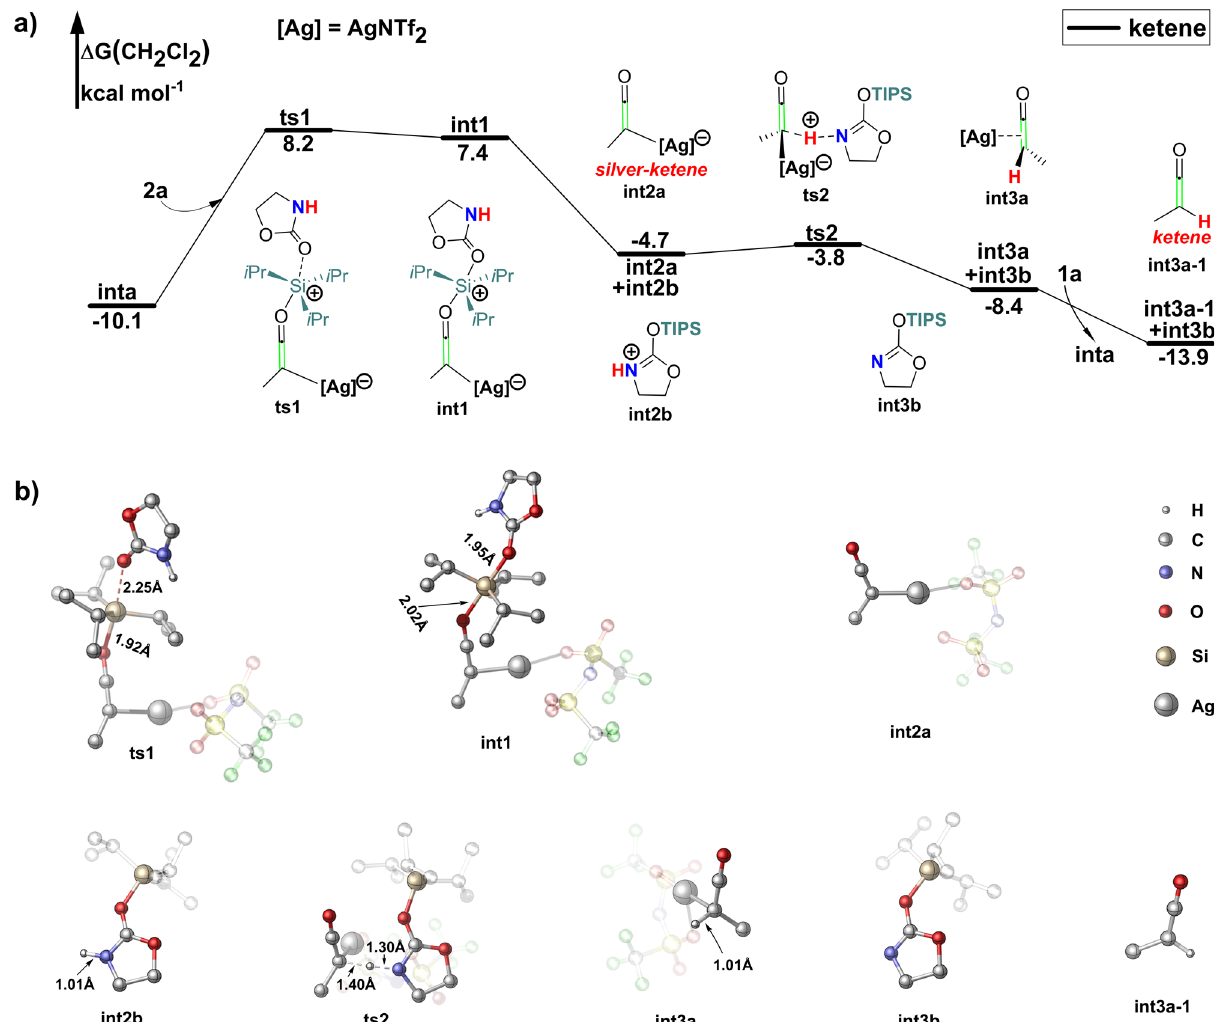
Fig. 4 Ag + induced silylium ion and proton exchange between siloxy-alkyne and amide. a Gibbs free-energy pro fi le. Gibbs energies are in kcal mol − 1 . b Optimized geometries. The hydrogen atom was omitted, and NTf 2 - anion was set to transparent for clarity. Except for ts1 and int1 , the isopropyl of the triisopropylsilyl (TIPS) group was set to transparent for